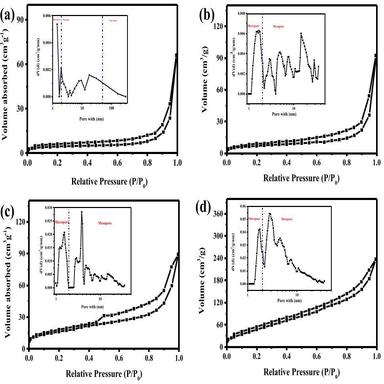
Nitrogen adsorption/desorption isotherms and BJH pore size distributions (inset) for (a) pure Fe3O4, (b) Fe3O4@CTP QDs-1, (c) Fe3O4@CTP QDs-2 and (d) Fe3O4@CTP QDs-3.